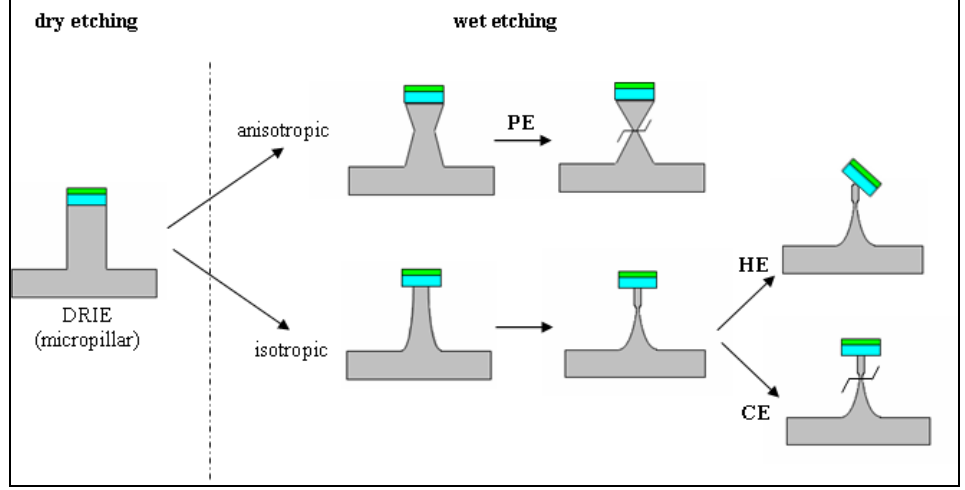
Figure 4. Schematics of the etching process for 3D electrodes of different shapes.